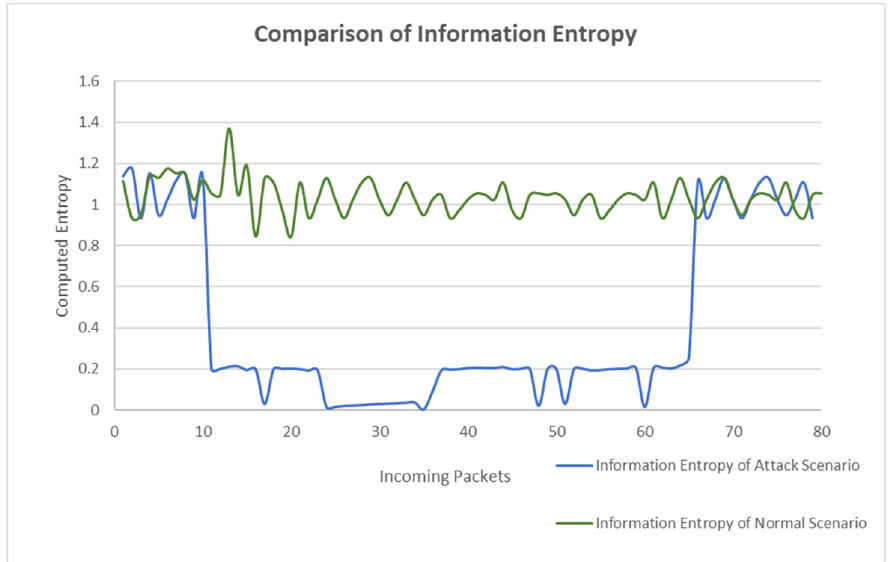
Figure 4. Information entropy variation.